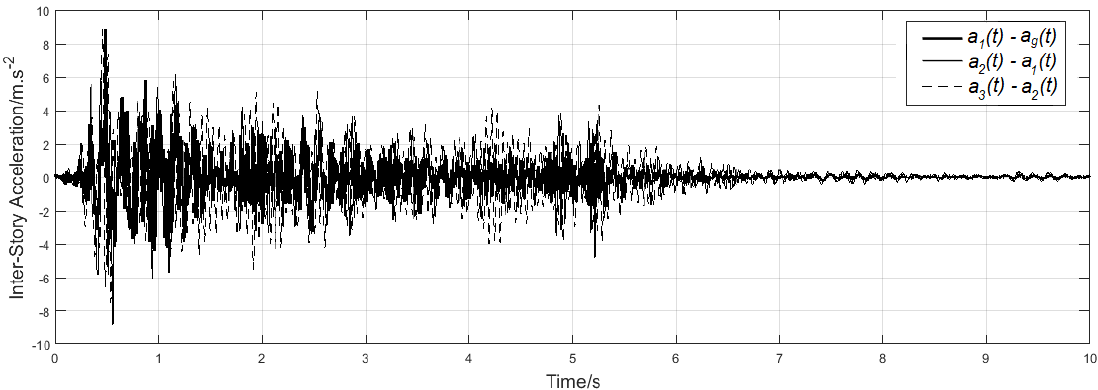
Figure 14. Inter-storey velocity, under seismic excitation, using the PSO/BELBIC controller.